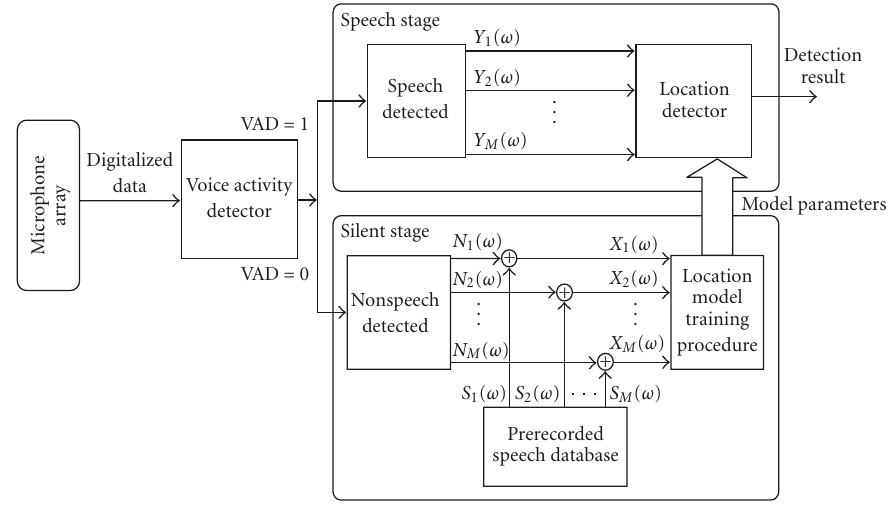
Figure 1: Overall system